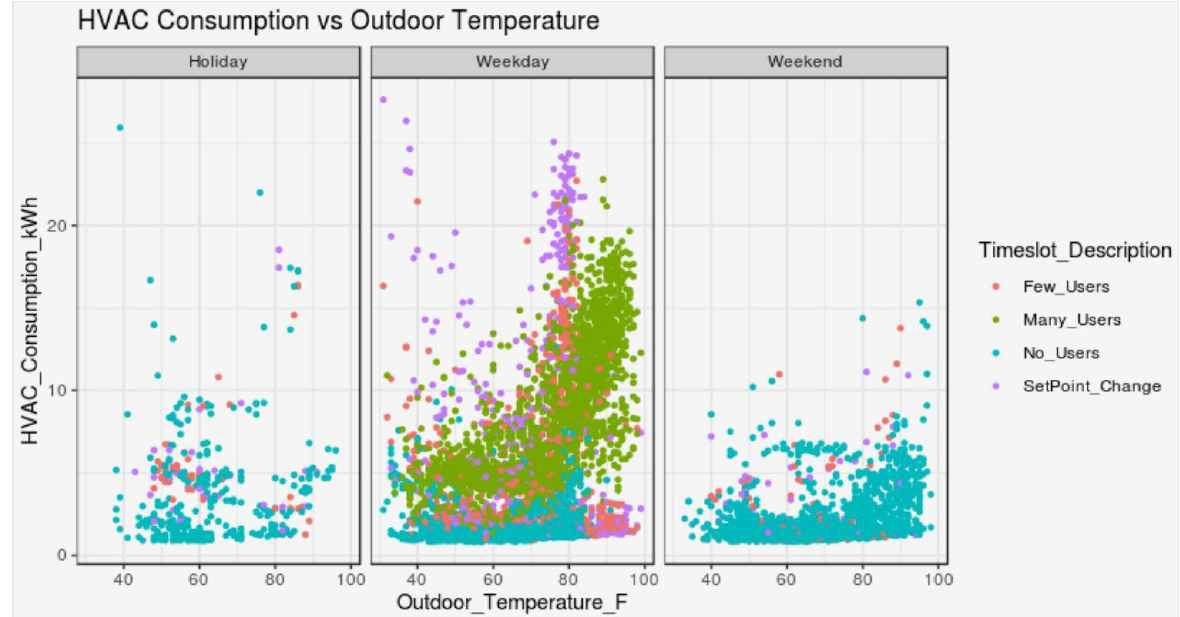
Figure 8. HVAC consumption vs. outdoor temperature .